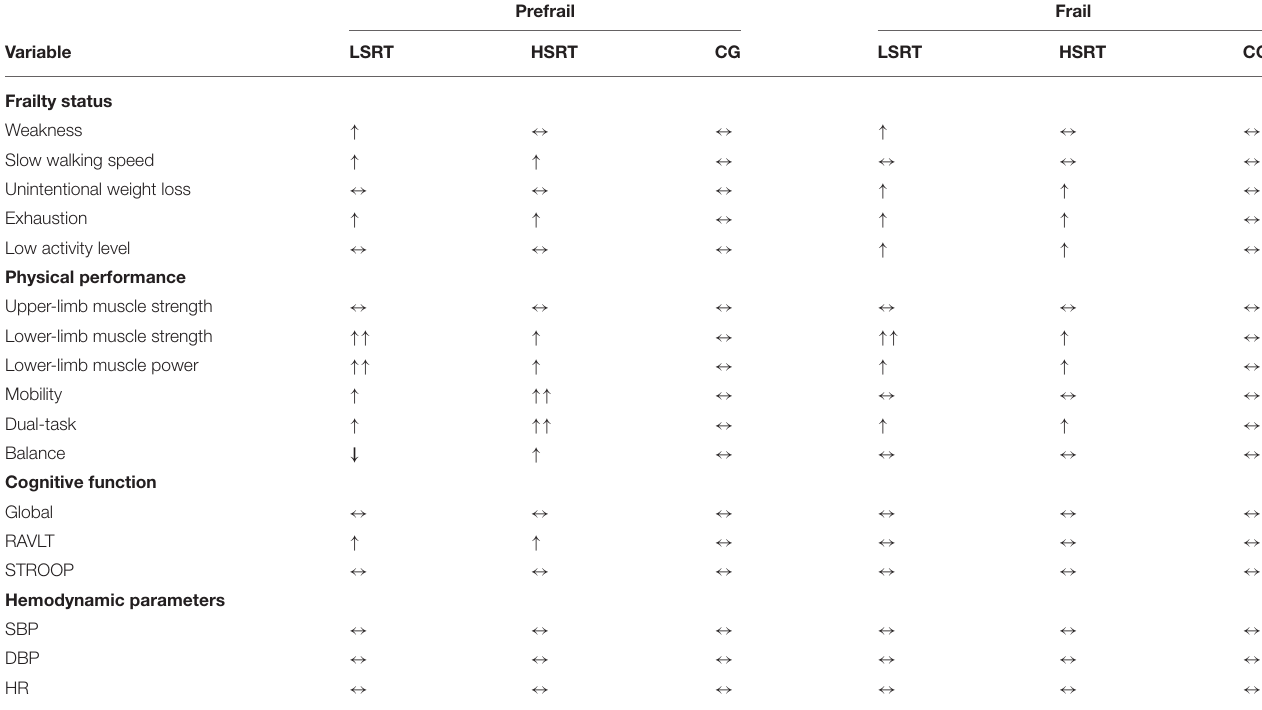
TABLE 4 | Effects of RT on frailty status, physical performance, cognitive function, and blood pressure and heart rate of prefrail and frail people.